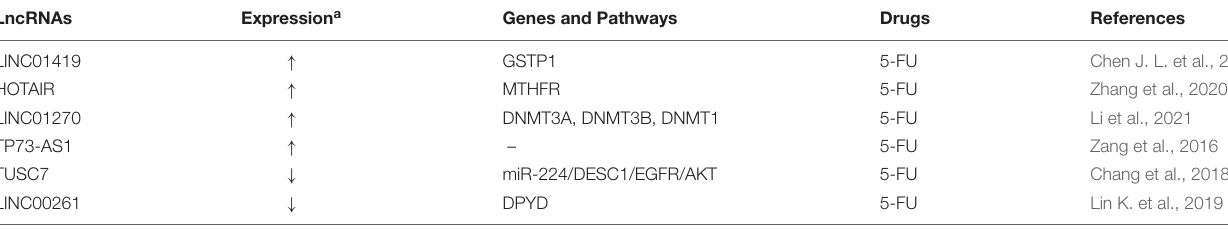
TABLE 5 | Long non-coding RNAs (lncRNAs) and 5-FU resistance in esophageal cancer. LncRNAs Expression a Genes and Pathways